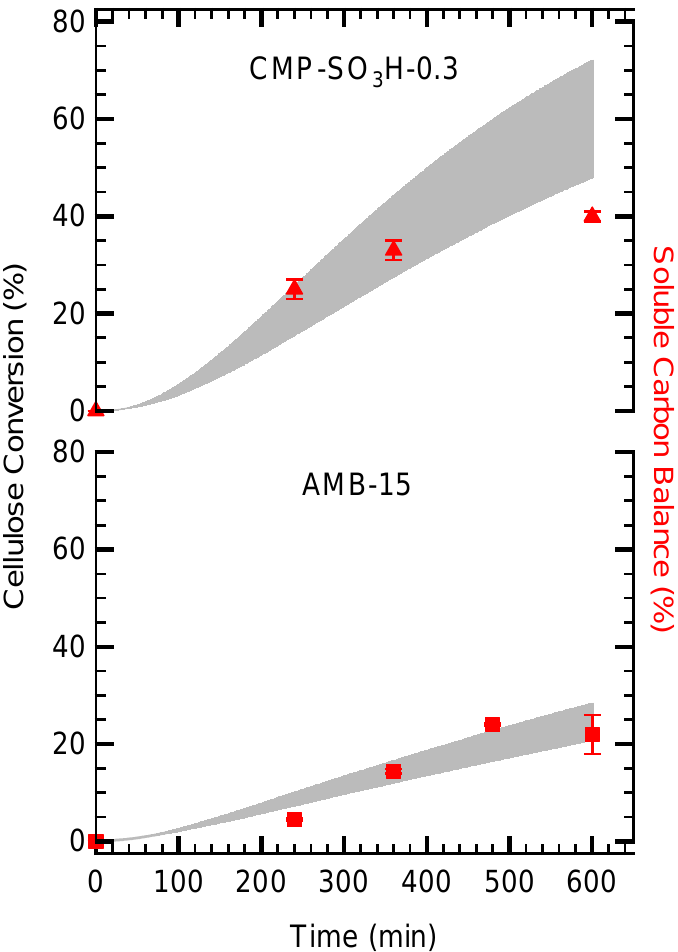
Figure 5. Comparison of cellulose conversion (gray) predicted by using Saeman’s homogeneous acid cellulose hydrolysis model and time-dependent acid concentration and measured soluble carbon balance (red) as a function of reaction time. Data presented are for CMP-SO 3 H-0.3 (top) and AMB-15 (bottom).